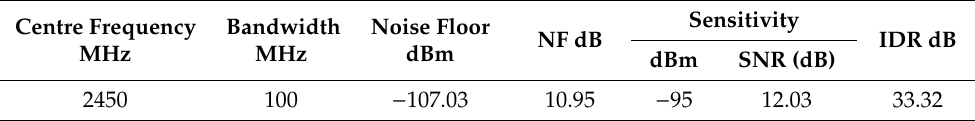
Figure 1. Received Power versus SNR in 2.4–2.5 GHz. Table 2. Performance parameters of SE in 2.4–2.5 GHz.